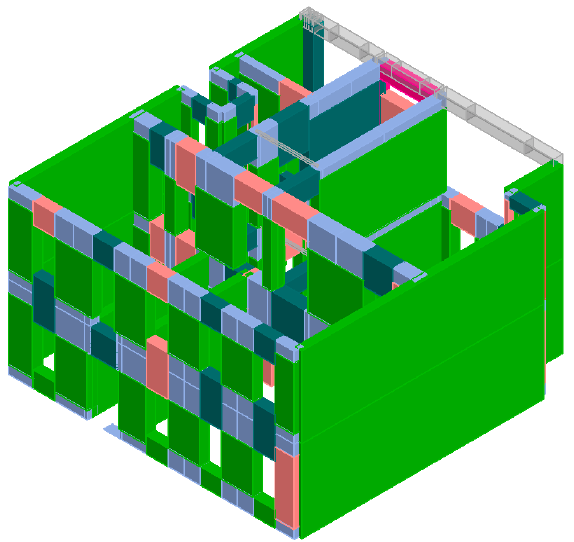
Figure 14. Damage at maximum displacement capacity for pushover in the X direction.